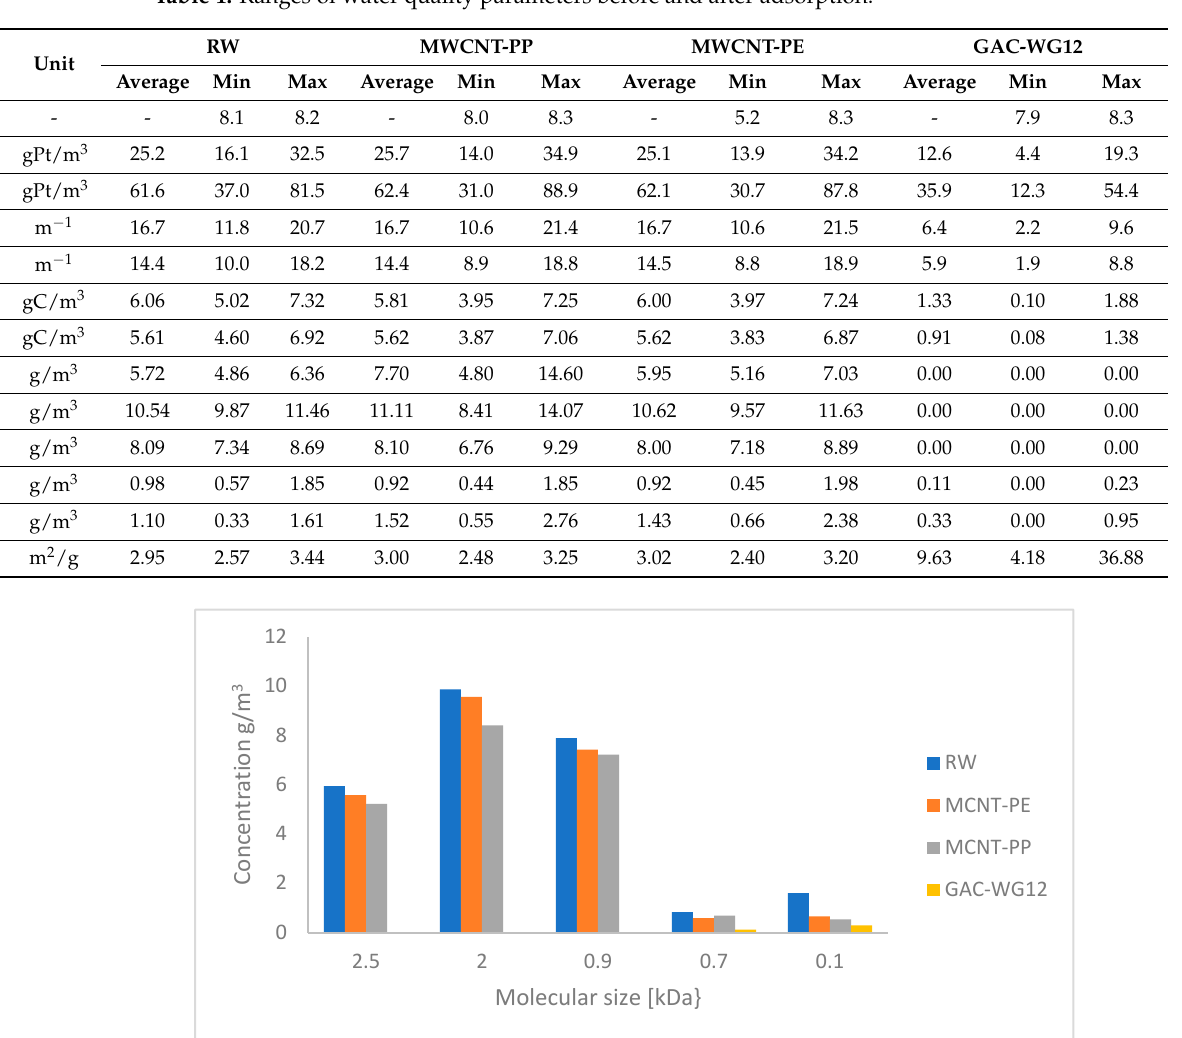
5 of 12 Table 1. Ranges of water quality parameters before and after adsorption. Parameter Unit